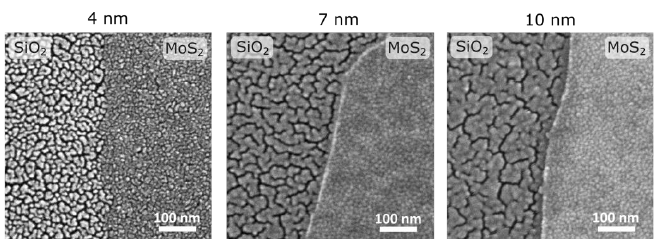
Figure A1. The comparison SEM images for gold films grown on SiO 2 and MoS 2 for 4 nm, 7 nm, and 10 nm film thickness.